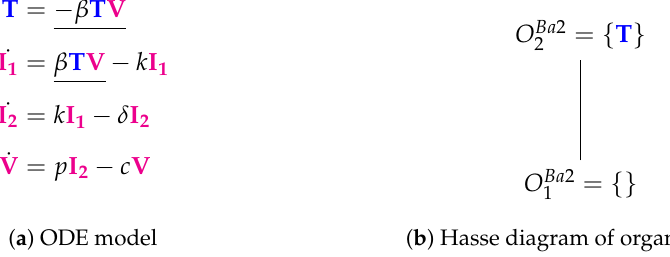
Figure 4. The Baccam II Model [13] with delayed virus production and four variables: uninfected (susceptible) target cells ( T ), infected cells not yet producing virus ( I 1 ), infected cells actively producing virus ( I 2 ) and infectious-viral titer ( V